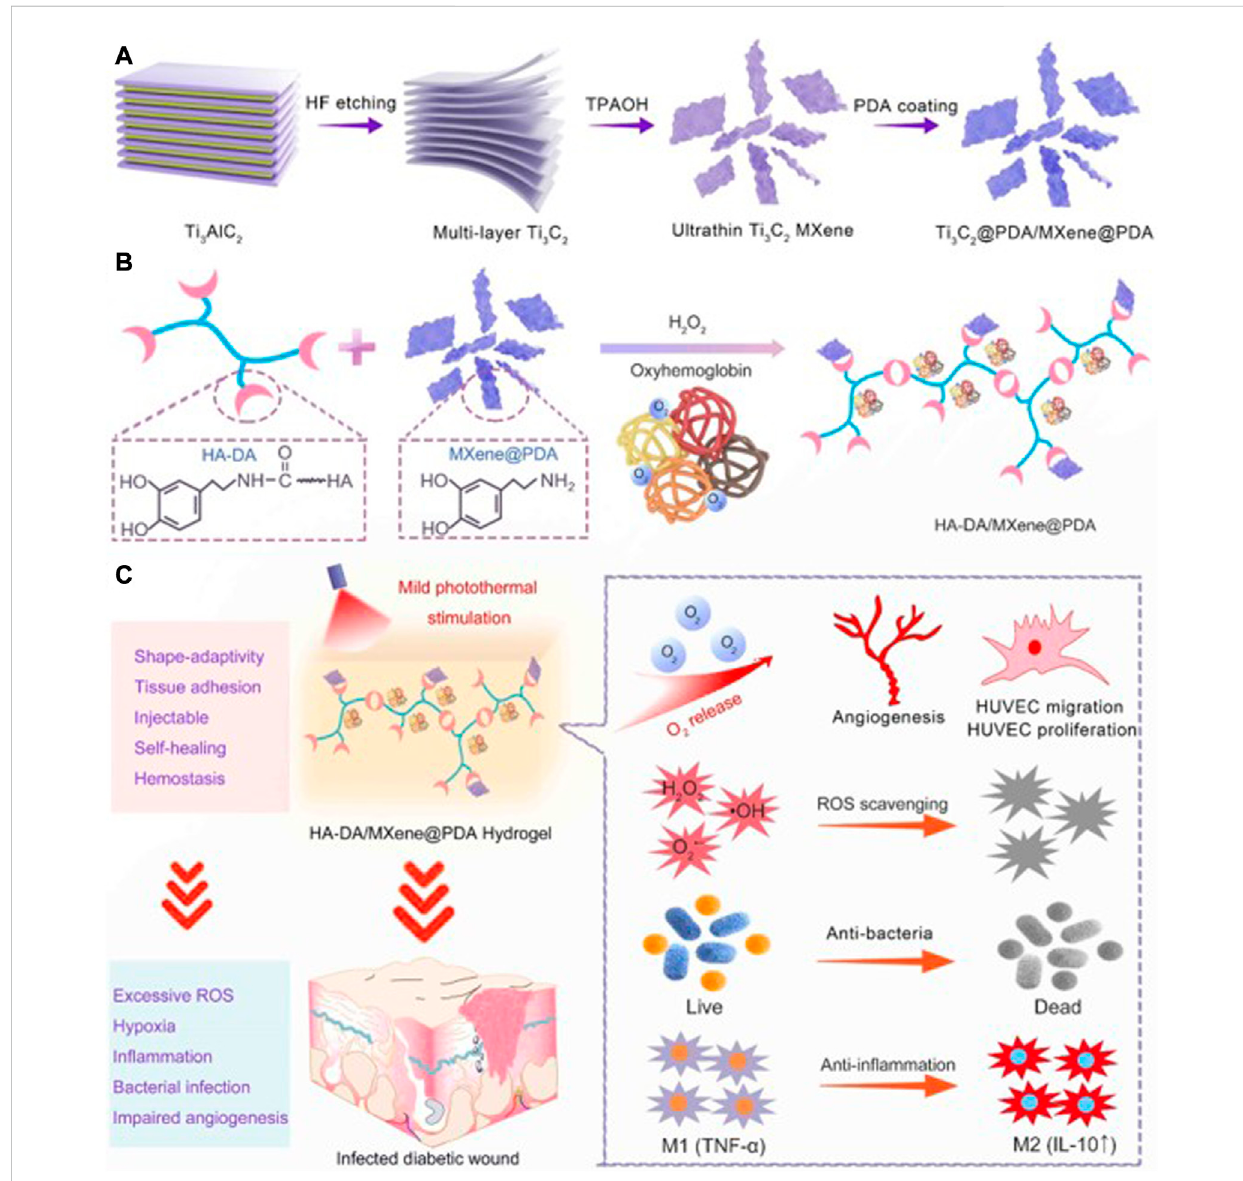
Schematic illustration of MXene@PDA Nanosheets. (A) Synthesis Diagram of MXene@PDA Nanosheets. (B) Schematic Illustrations of Injectable HA- DA/MXene@PDA Hydrogel Preparation. (C) Infected Diabetic Wound Healing Mechanism of HA-DA/MXene@PDA Hydrogel through Supplying O2, Scavenging ROS, Eradicating Bacteria, and Inhibiting In fl ammation. (Li et al.,